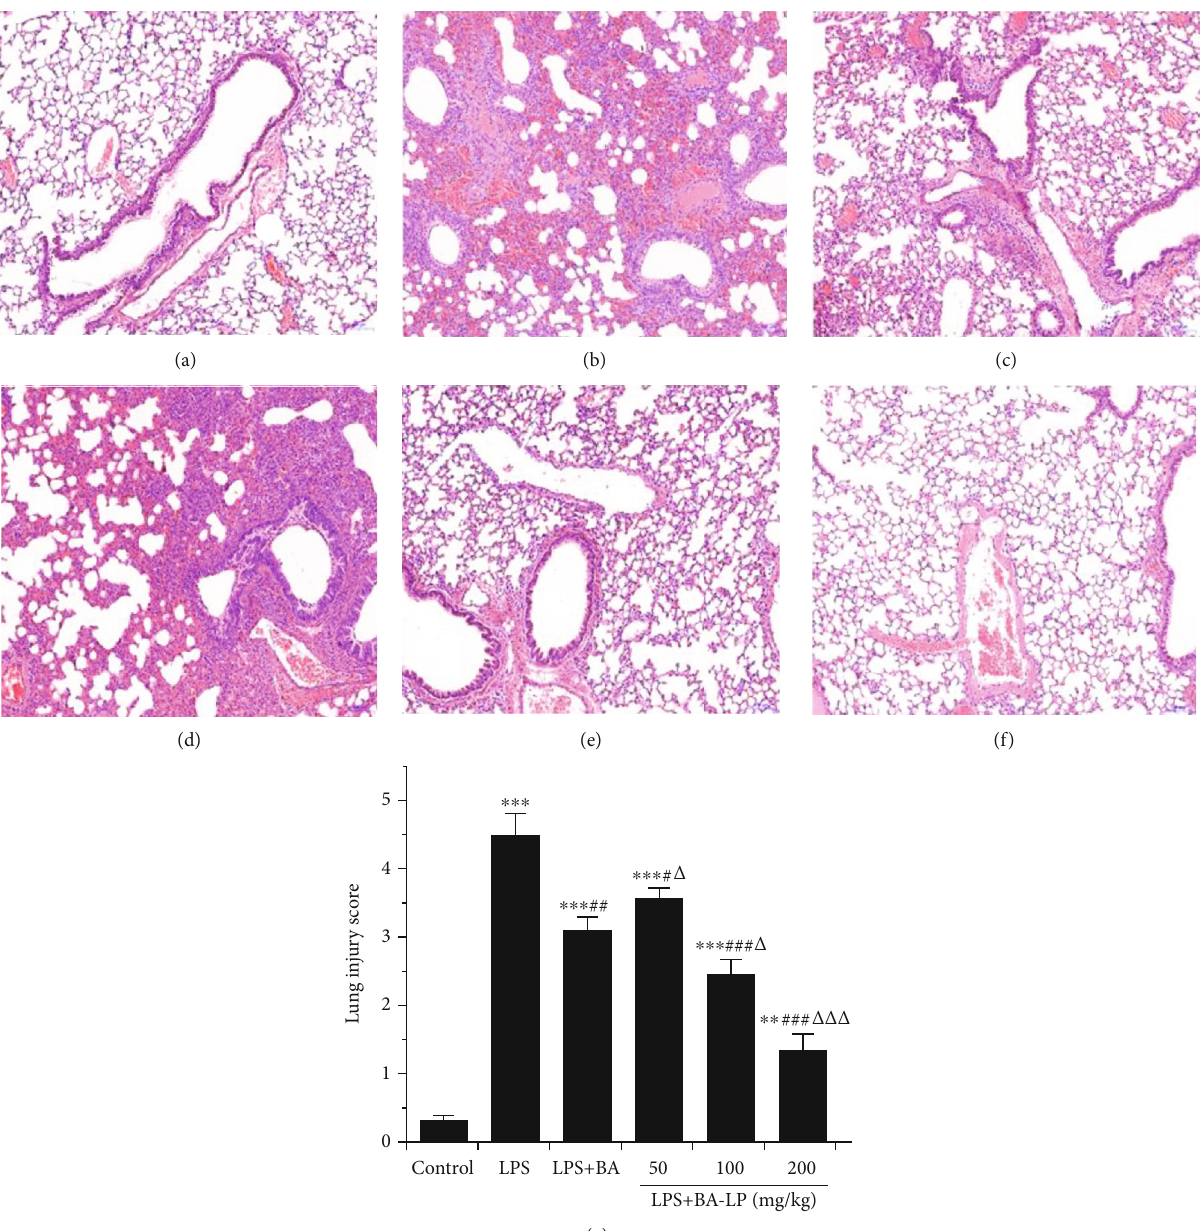
Figure 3: The e ff ect of BA on lung tissue histopathological changes. Histopathologic sections of lung tissues (H&E, × 100): (a) control group, (b) LPS group, (c) LPS+BA (100mg/kg), (d) LPS+BA-LP (50 mg/kg), (e) LPS+BA-LP (100mg/kg), and (f) LPS+BA-LP (200mg/kg) mice. (g) The pathological scores was evaluated during ALI. The values were presented as means ± SD ( n = 5 ). ∗ P < 0 : 05 , ∗∗ P < 0 : 01 , and ∗∗∗ P < 0 : 001 vs. the control group; # P < 0 : 05 , ## P < 0 : 05 , and ### P < 0 : 01 vs. the LPS group; and △ P < 0 : 05 , △△ P < 0 : 01 , and △△△ P < 0 : 001 vs. the LPS+BA